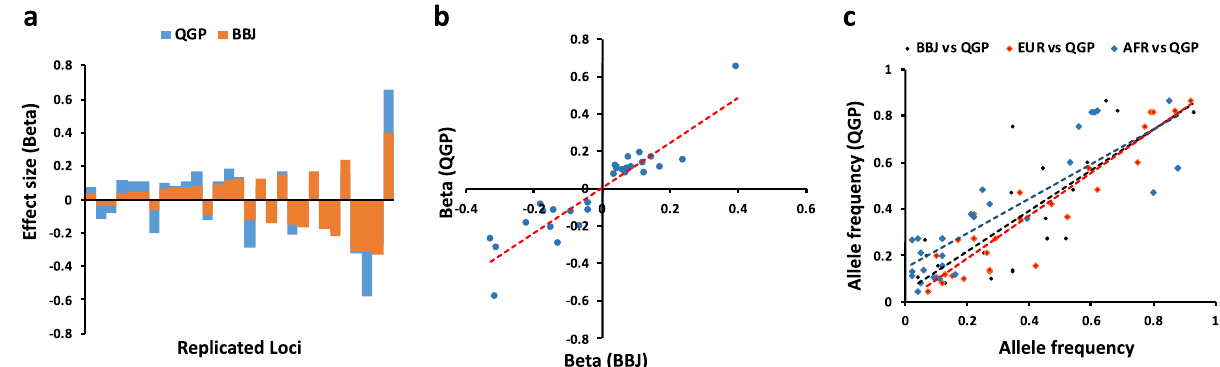
Fig. 4 Comparison of allele frequency and effect size for known loci. a The effect size (Beta) for loci showing replication after correction for multiple testing in QGP (blue bars) compared to Biobank Japan project (BBJ 7 , orange bars). b Correlation of effect size for replicated loci between QGP and BBJ. c Correlation of allele frequency for replicated loci between QGP and BBJ ( r = 0.80), QGP and European (EUR; r = 0.94), or QGP and African (AFR; r = 0.85) populations. Dotted lines represent lines of best fi t from regression analysis.